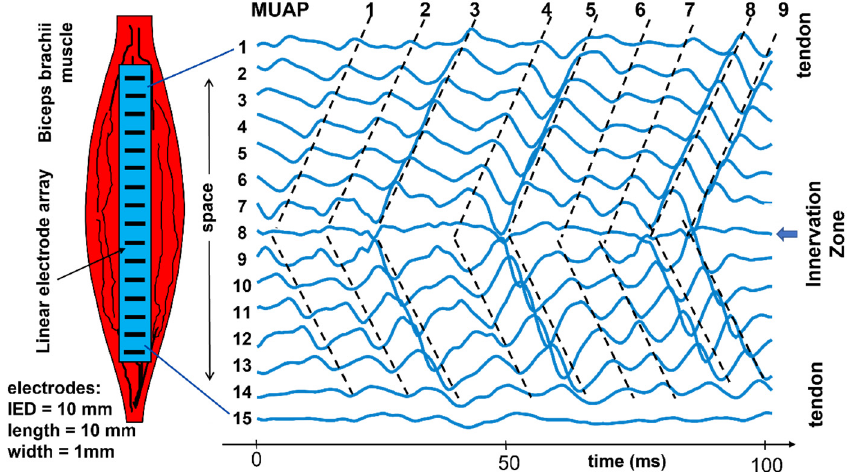
Figure 8. Example of experimental sEMG signals recorded with 15 single differential channels from a biceps brachii. We can see the “signatures” of at least 9 MUs, locate their innervation zones, and estimate their length and conduction velocity (CV). The slopes of the dashed lines are the CVs of the motor unit action potentials (MUAPs). This piece of information cannot be obtained by one pair of electrodes and requires detection by an array of electrodes placed along the muscle fiber direction, as in Figure 7. IED = interelectrode distance. Modified from https://www.robertomerletti.it/en/emg/material/teaching/module6.